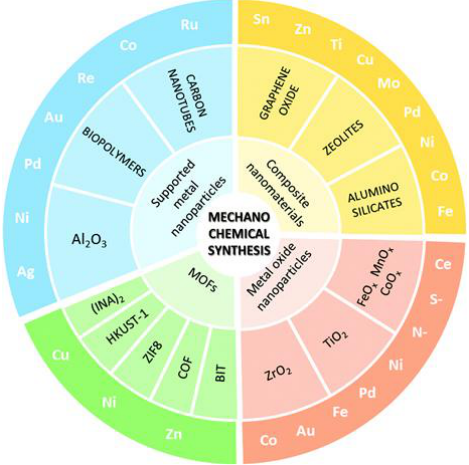
Scheme 9. Pictorial representation of different types of MC synthesized (nano)materials.